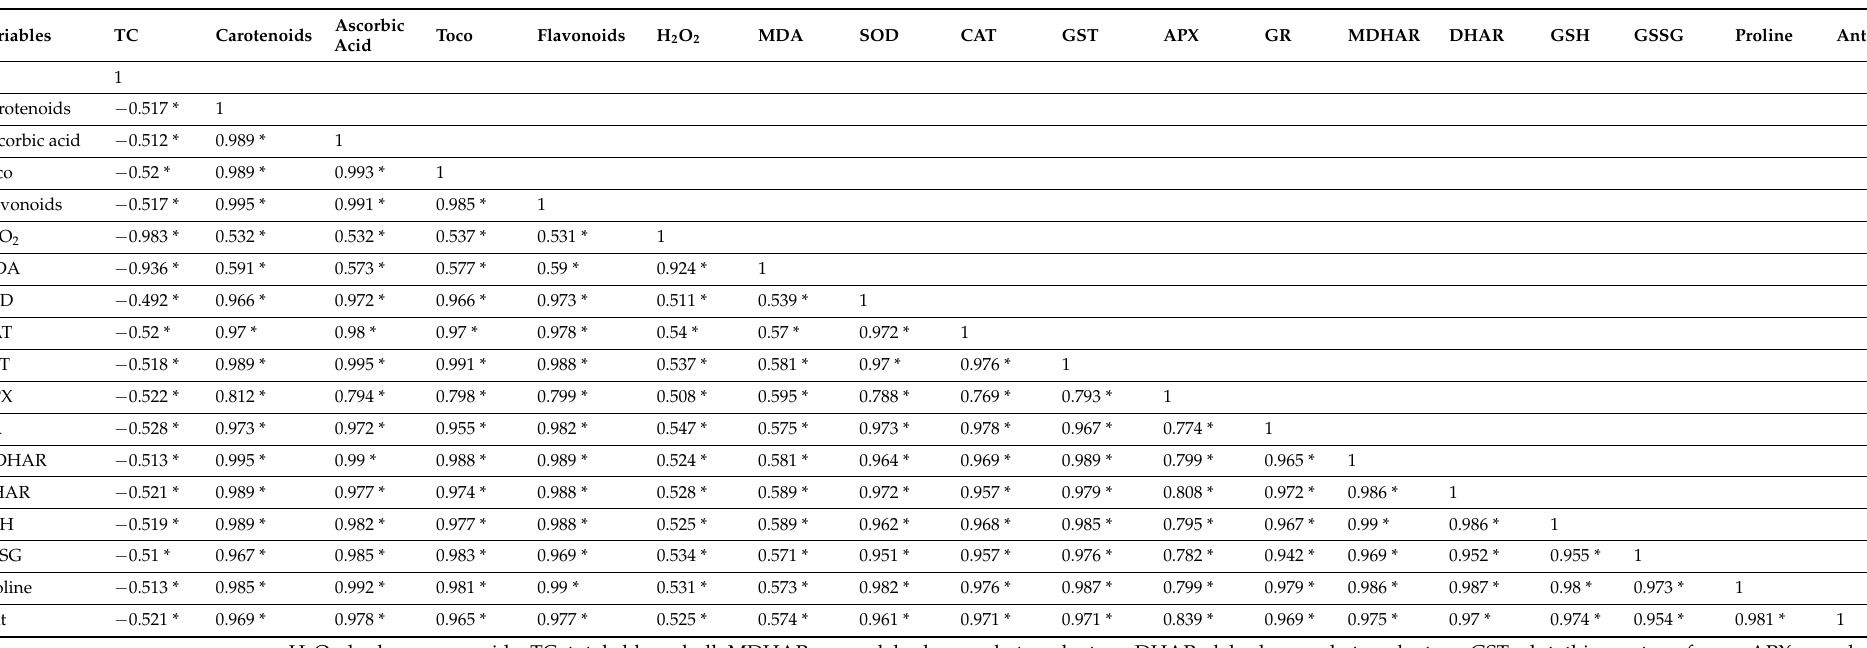
Table 2. Spearman correlation matrix showing significant correlation among various physiochemical parameters of tomato plants raised through SeNPs-primed